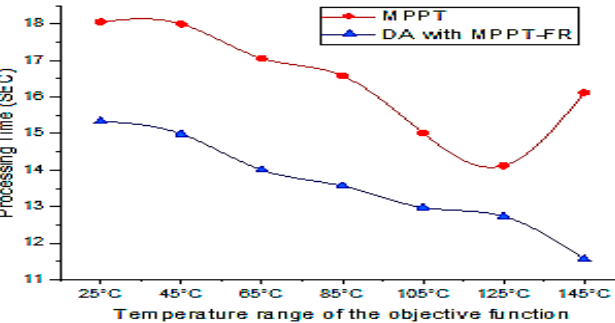
Figure 12. Temperature vs. processing time of MPPT and DA with the MPPT-FR algorithm.